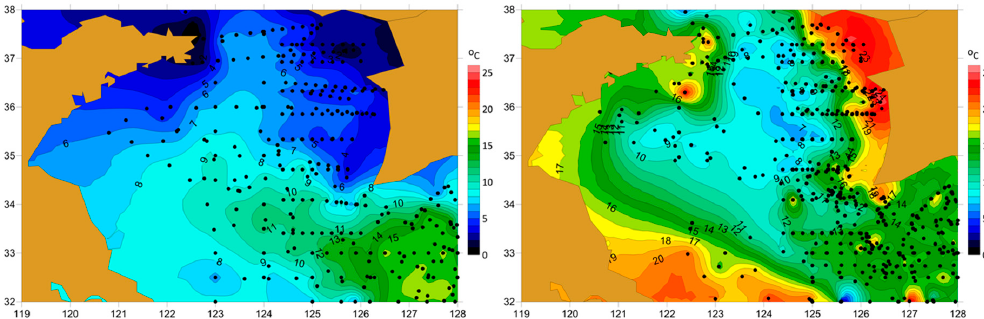
Figure 8. Interpolated sediment TOC concentrations in the Yellow Sea.